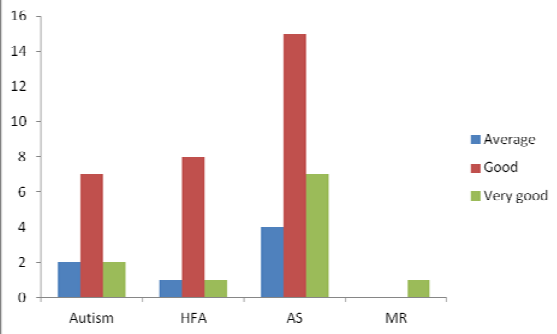
Fig. 6: Family economy in different children